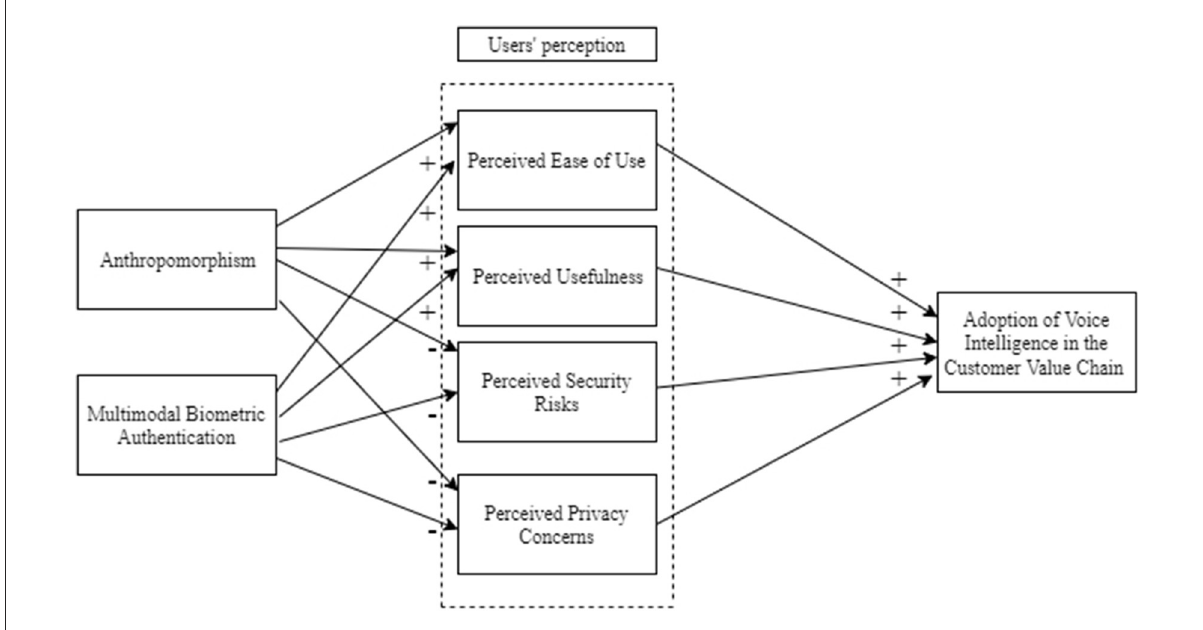
FIGURE1 Research